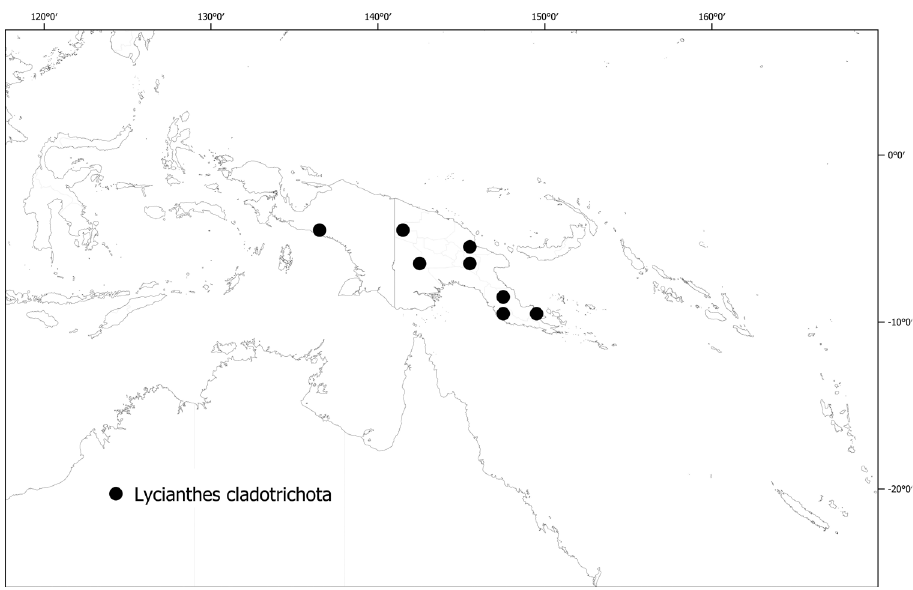
Figure 18. Distribution of Lycianthes cladotrichota